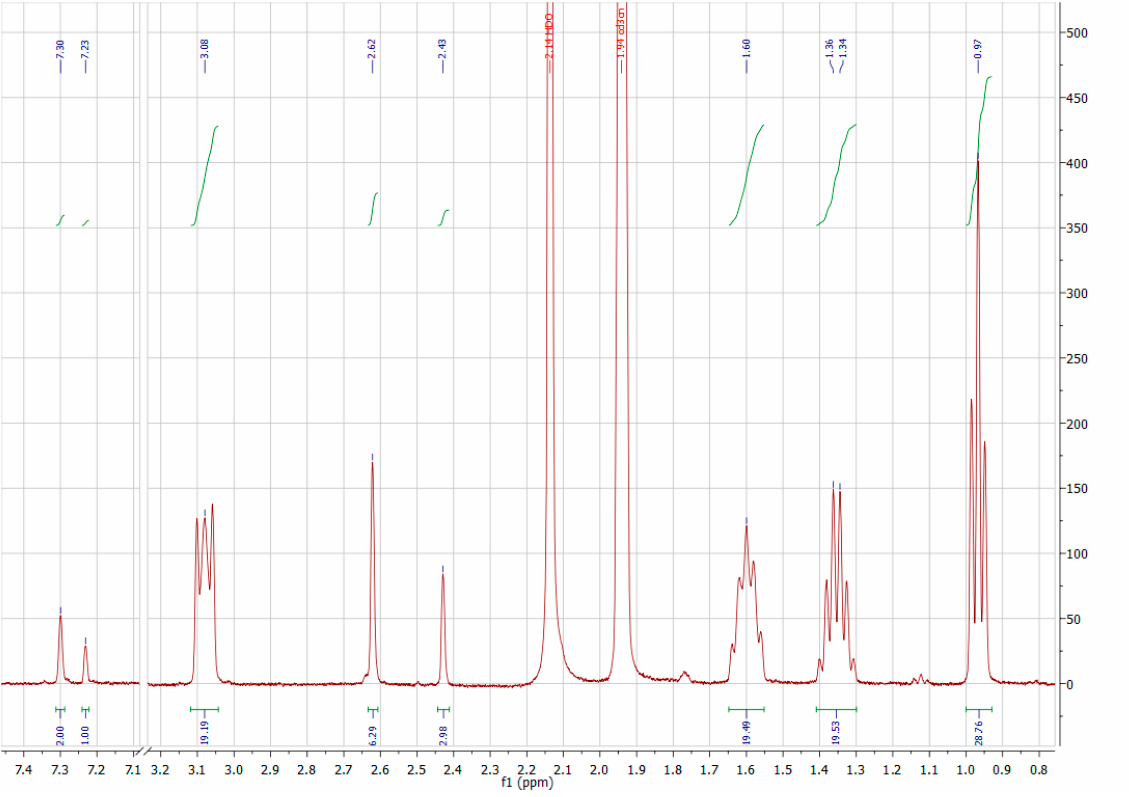
Figure A7. NMR Spectrum (400 MHz) of ( 1-L4 ) in